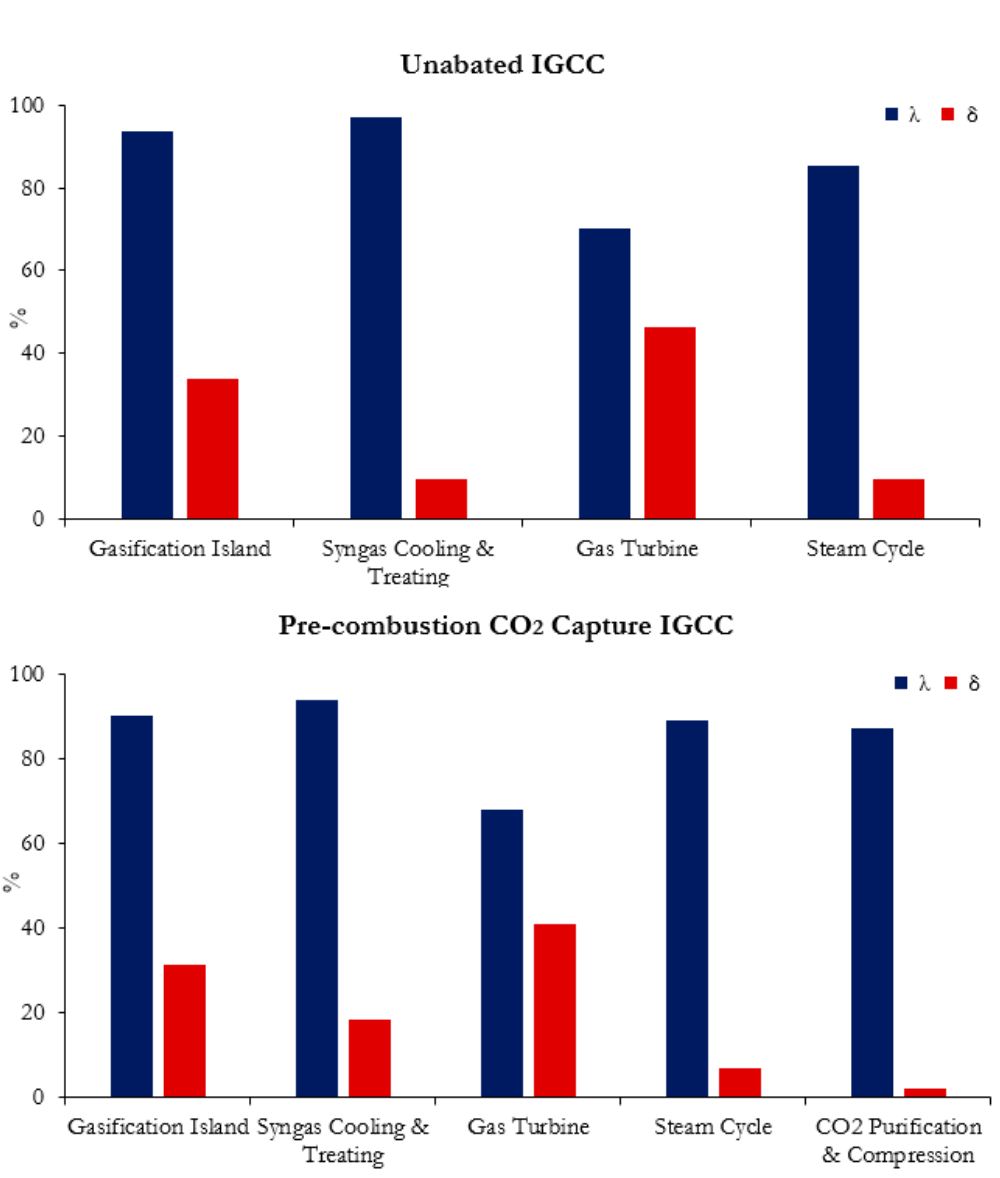
Figure 8. Exergy utilization λ and exergy destruction contribution δ in percent for the benchmark power plants, as defined by Equations (4) and (5).